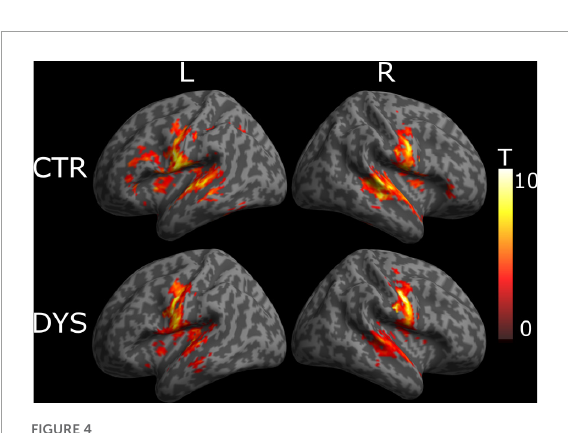
FIGURE5 Univariate whole-brain results of the deactivation/repetition effect (a decreased activation across repetitions that fit a linear function). Statistical t-maps for dyslexic readers (DYS) and controls (CTR) are projected on left (L) and right (R) cortical surfaces (from MNI standard human cortex) using an uncorrected voxel-wise threshold of p < 0.001 and a cluster-wise threshold with FDR correction of q < 0.05.